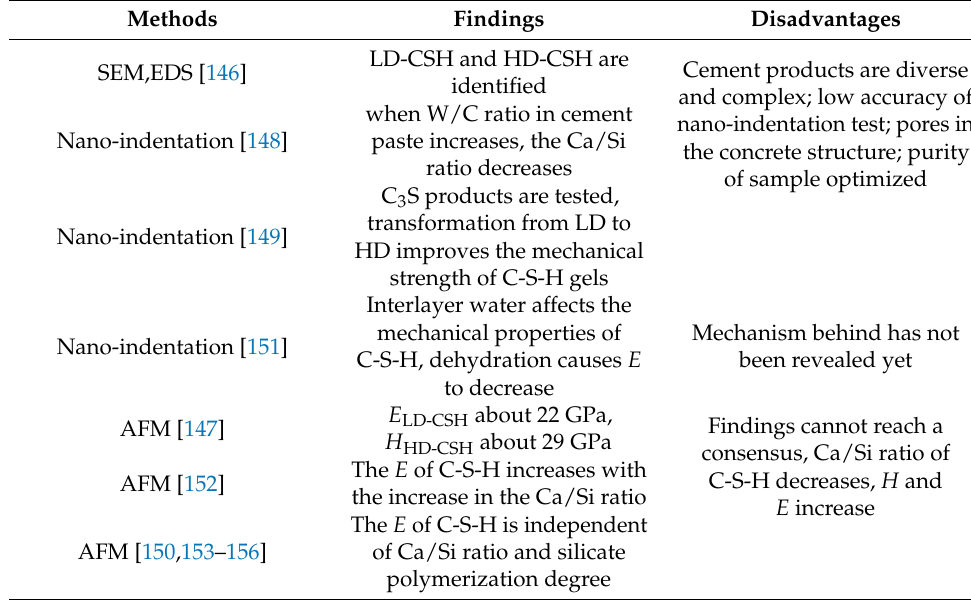
Table 5. Mechanical experiment of